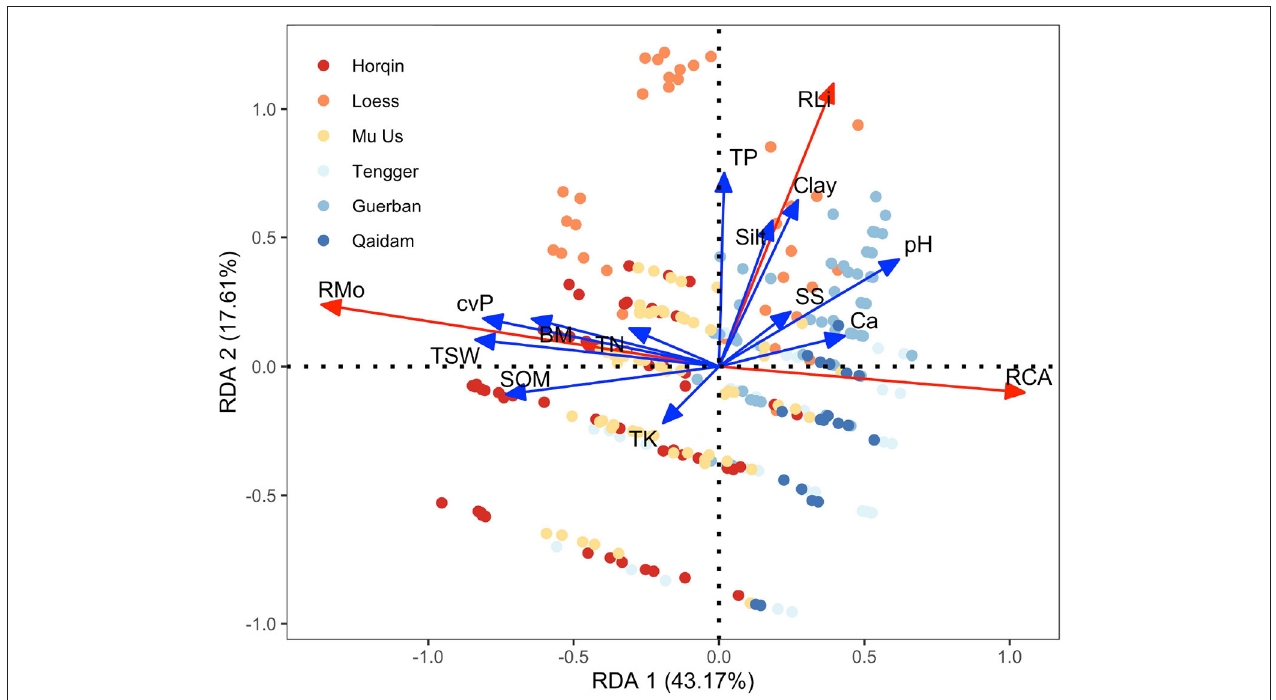
FIGURE 6 | Redundancy analysis (RDA) ordination triplot showing the relationships between the environmental variables (TK, TP, SOM, BM, cvP, TSW, CA, SS, pH, Clay, Silt, and TP, marked with blue arrows) and the variations in the species richness of biocrust components (mosses, lichens, and cyanobacteria-algae, marked with red arrows). Different points indicate the samples obtained from the six study sites across the desert regions of northern China.